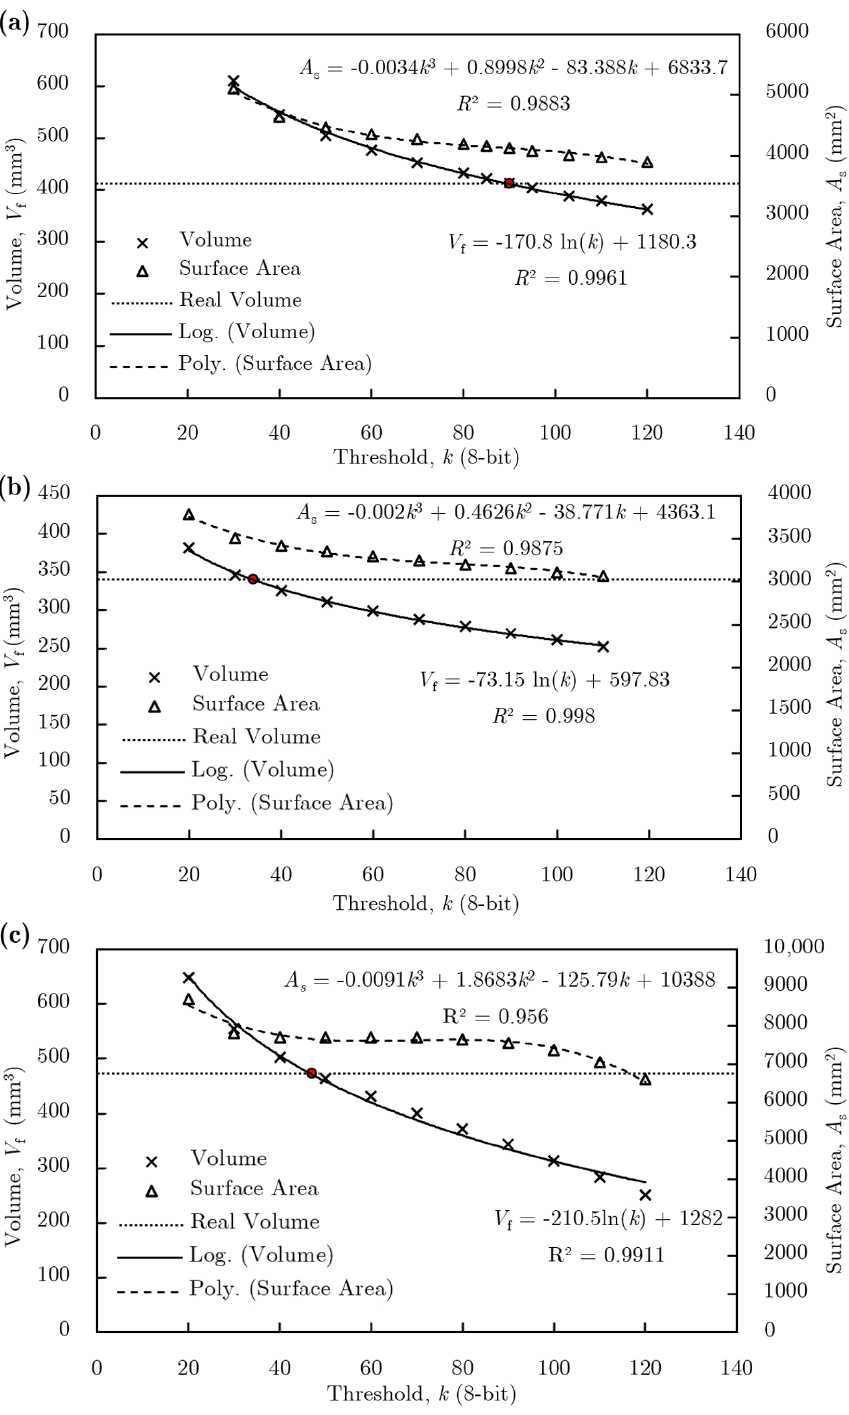
Figure 3. Threshold sensitivity analysis for the ( a ) cubic open-cell, ( b ) cylindrical open-cell and ( c ) closed- cell foam specimens. Red point represents intersection of real volume with the volume